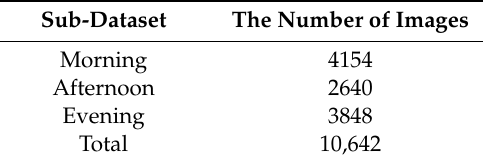
Table 4. Descriptions of SMBD-DB1.